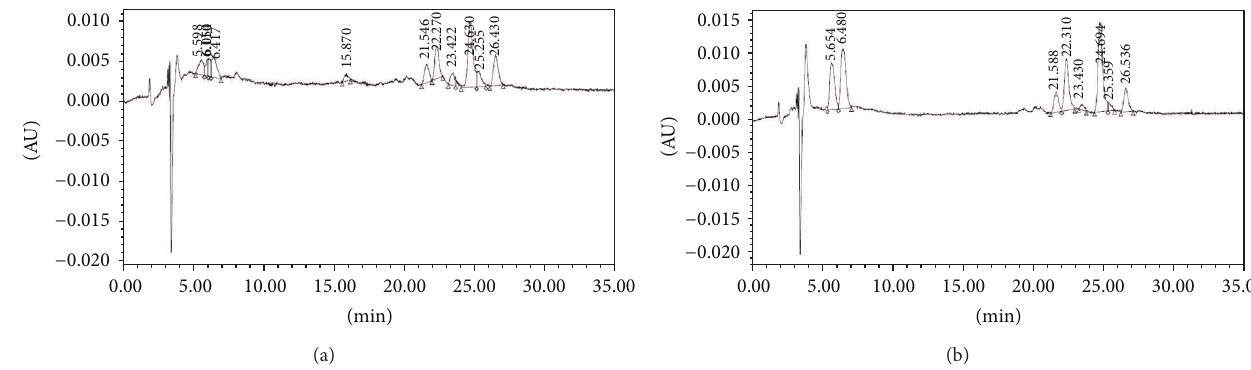
Figure 8: (a) Chromatogram of 𝛽 -carotene of fresh arachis oil. (b) Chromatogram of 𝛽 -carotene of heated arachis